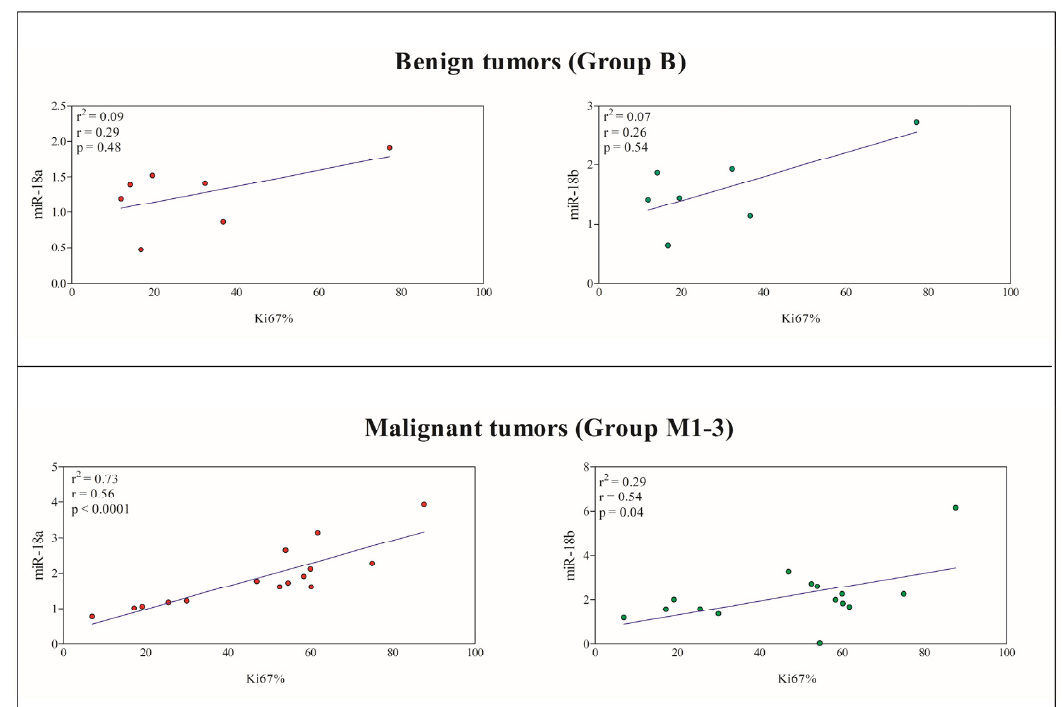
Figure 5. Linear regression obtained between the Ki67 index and the expression of miR-18a (red circles) and miR-18b (green circles) in benign tumors (Group B) and malignant tumors (Group M1–3). A significant positive correlation was found between the Ki67 index and the miR-18a and miR-18b expression levels in malignant CMTs ( p < 0.05).